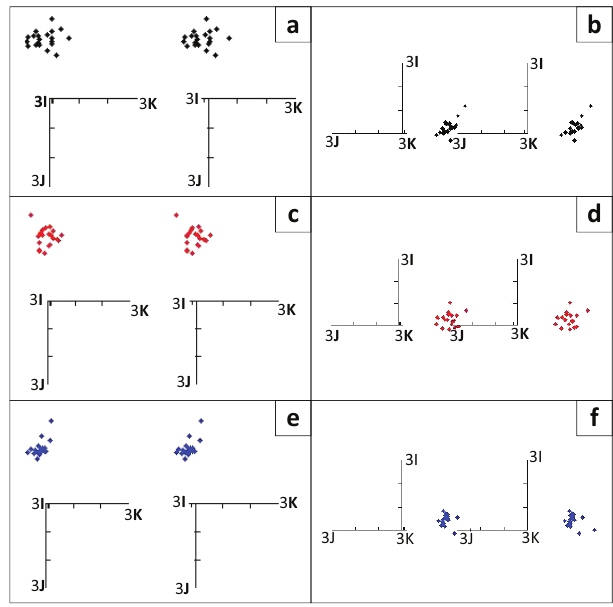
Note: Measurement s are viewed down the stigmatic axis in a, c and e and down the oblique antistigmatic axis in b, d and f. The stereo-pair scatter plot has an axis length of 3 D, origin is placed at 53 I D and the tick interval is 1 D. FIGURE 4: (a ‒ f) Rotated stereo-pair scatter plots for the posterior surface of the cornea. Each data point represents one of 20 Pentacam measurements taken at the first (black data points), second (red data points) and third (blue data points) measuring